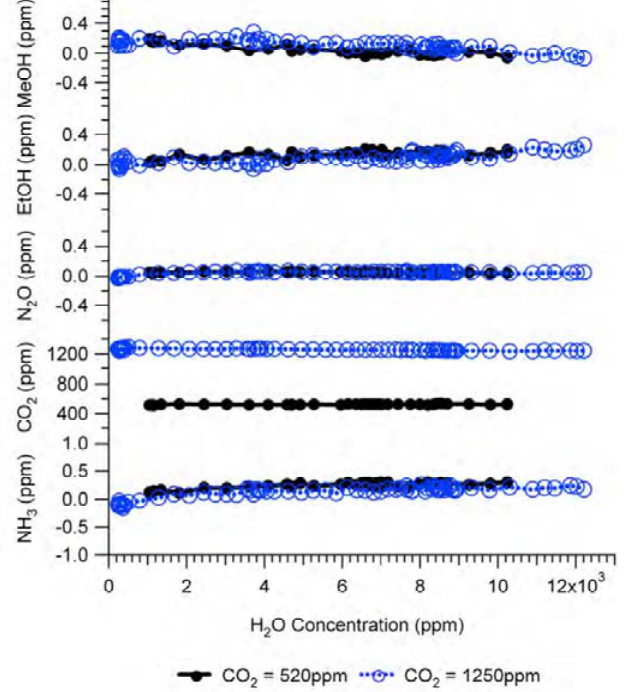
Figure 8. Interference of H O in Example #2 as a target gas. Black solid lines with closed 2 circles are experimental responses to 520 ppm CO and blue dashed lines with open circles 2 are experimental responses to 1,250 ppm CO . All other gases were 0 ppm. Analytical 2 results of the interference of H O as a target gas were not available because the IRSA 2 method is used to estimate the interference of non-target